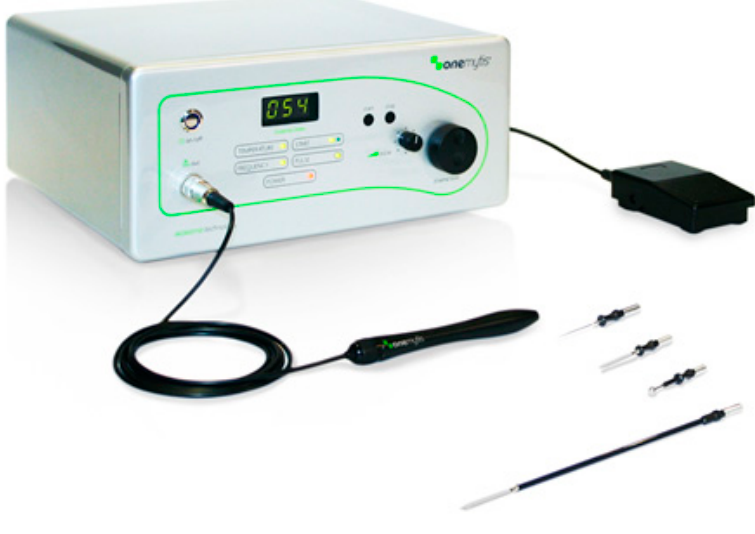
Figure 1. Onemytis ® device.